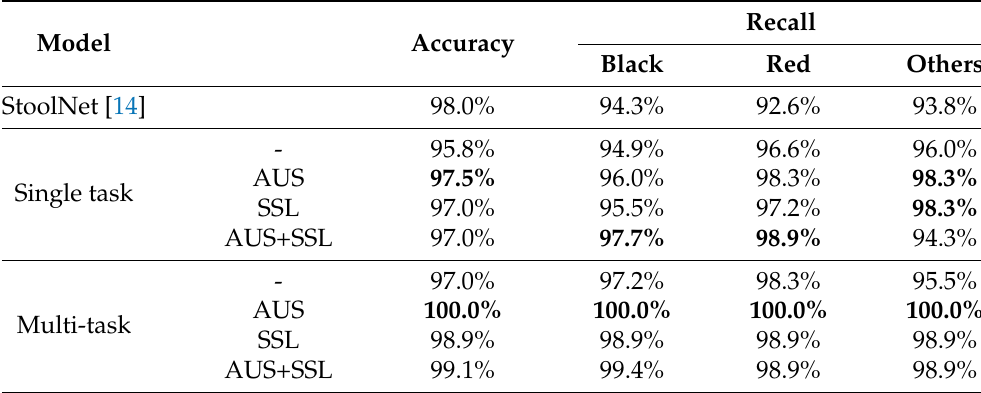
Table 4. Results for three color categories in medical scenes.